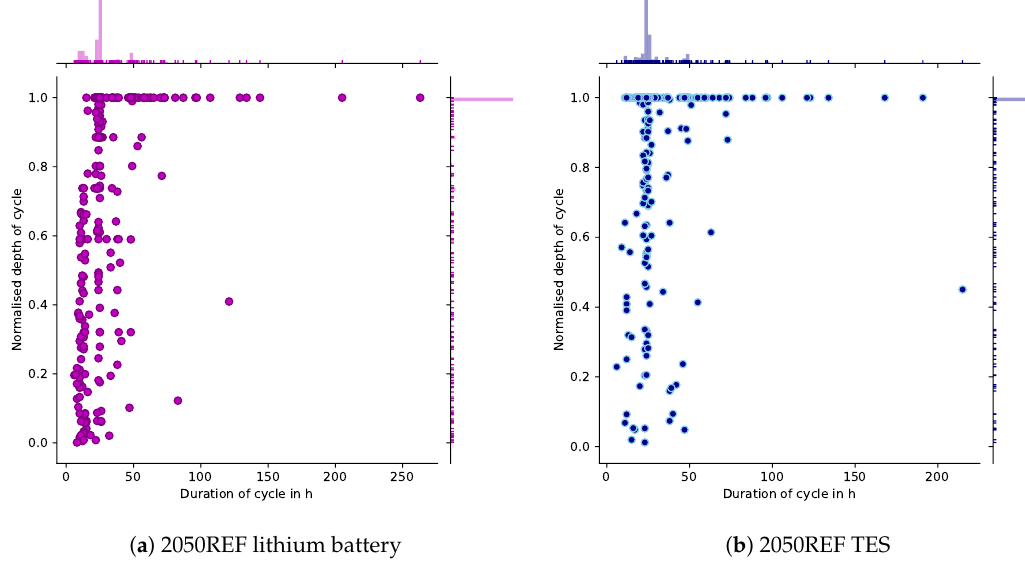
Figure 5. Storage cycles of lithium battery and TES for the 2050 scenario.